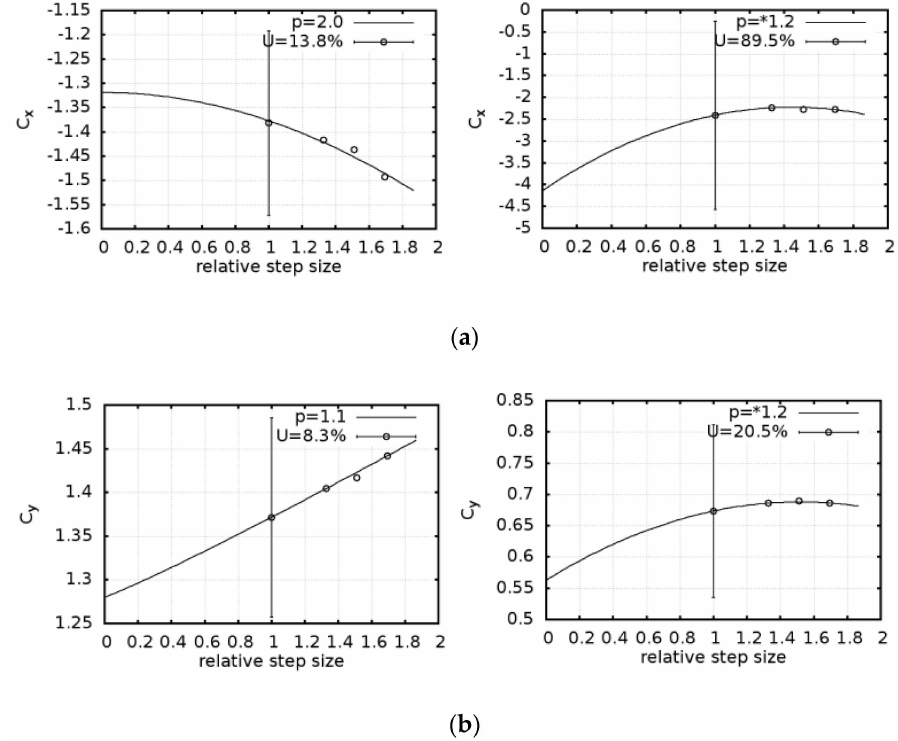
Figure 16. Verification results for the FPSO ( left ) and shuttle tanker ( right ). ( a ) C x at 180 ◦ heading; ( b ) C y at 90 ◦